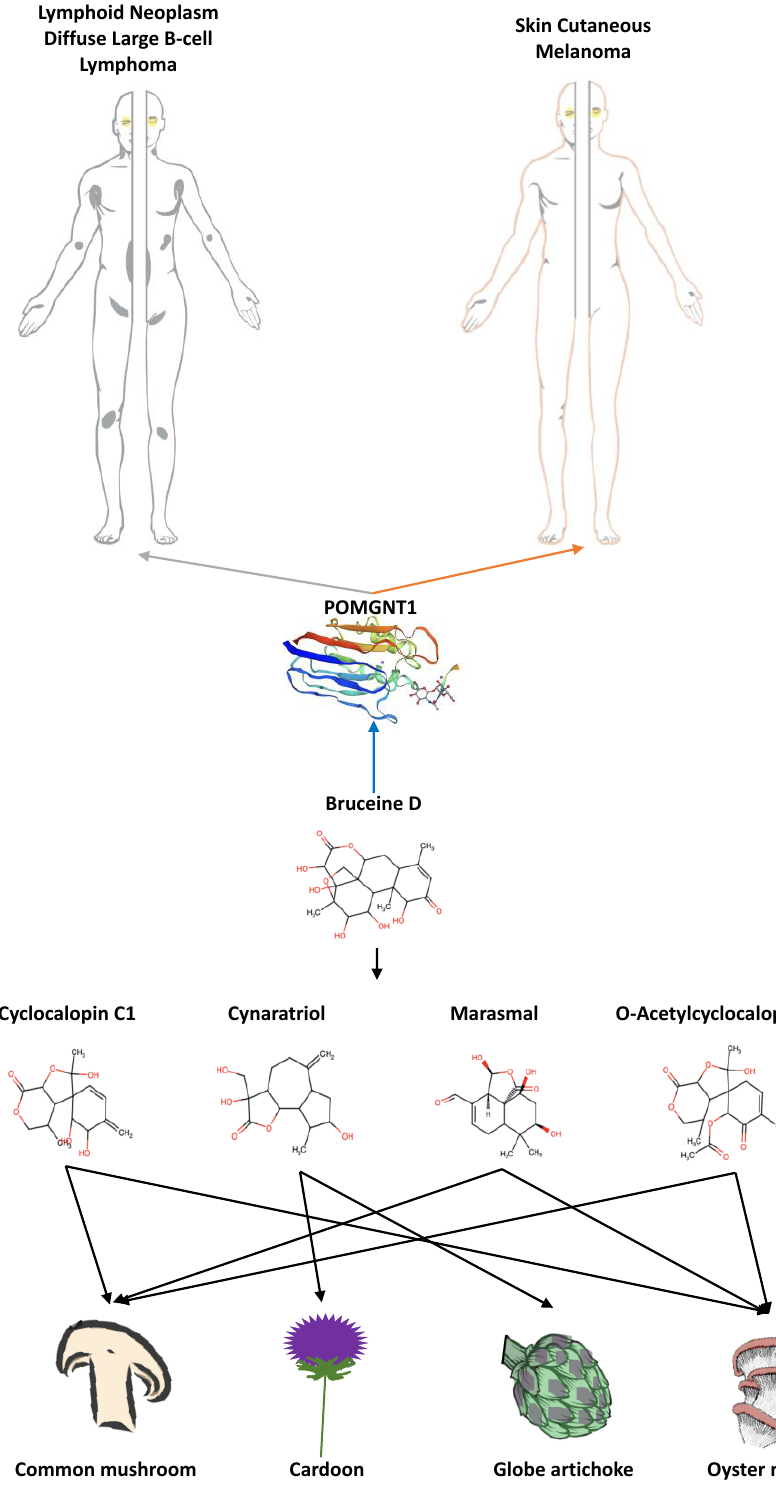
Figure 4. Potential novel foods useful in cancer treatments and/or prevention. Four new identified compounds that share similarity with Bruceine D and that could play a role in the regulation of genes that enhance the survival in lymphoid neoplasm diffuse large B-cell lymphoma and in skin cutaneous melanoma. O-Acetylcyclocalopin A, Marasmal and Cyclocalopin C1 are predicted in Oyster mushroom and in common mushroom. Cynaratriol is expected in cardoon and globe artichoke.